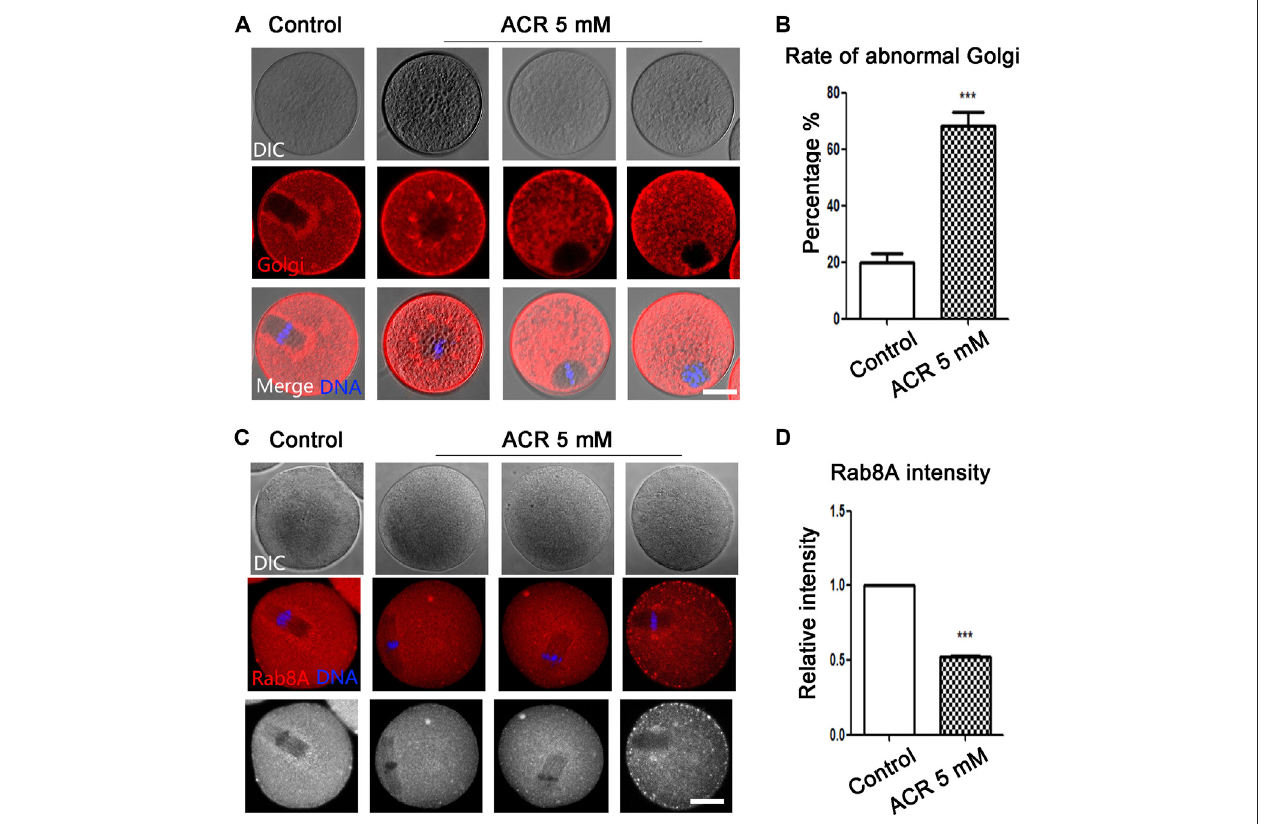
FIGURE4| ToxiceffectsofACRonthedistributionandvesicletransportcapacity oftheGolgiapparatus inoocytes. (A) Thetypicalpictureofthedistributionofthe Golgiapparatusinoocytes after treatment. TheGolgiapparatusfragmentwasobservedin theACR-exposed oocytes. Red, Golgi-Tracker;blue, DNA. Bar =30 μ m. (B) The abnormal rate of the Golgi apparatus increased signi fi cantly in 5 mM ACR groups. *** p < 0.001. (C) The typical fl uorescence picture of Rab8A after ACR treatment. Few Rab8A signals were observed in the ACR-exposed oocytes. Red, Rab8A. Blue, DNA. Bar = 30 μ m. (D) The fl uorescence intensity of Rab8A after ACR exposure was signi fi cantly lower than that of the control group. * p <